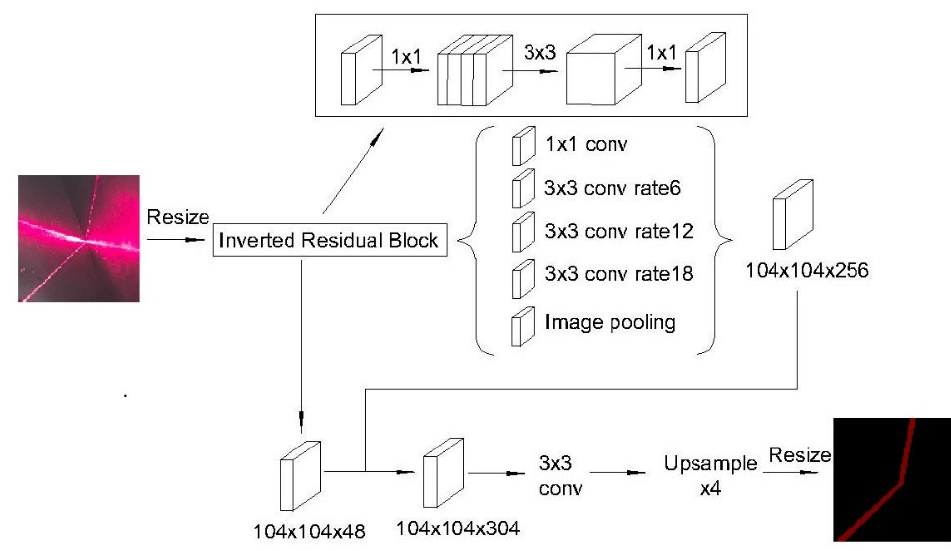
Figure 5. The DeeplabV3+ structure diagram.